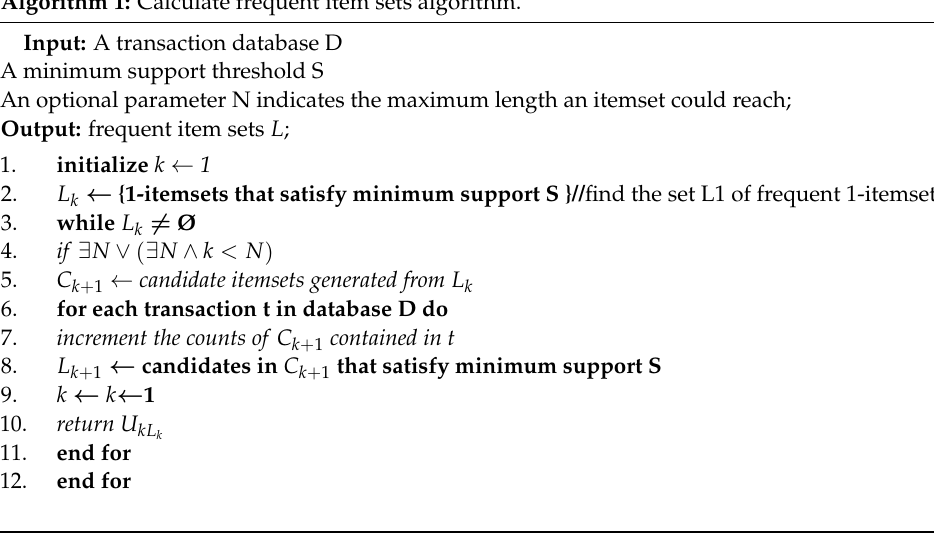
Algorithm 1: Calculate frequent item sets